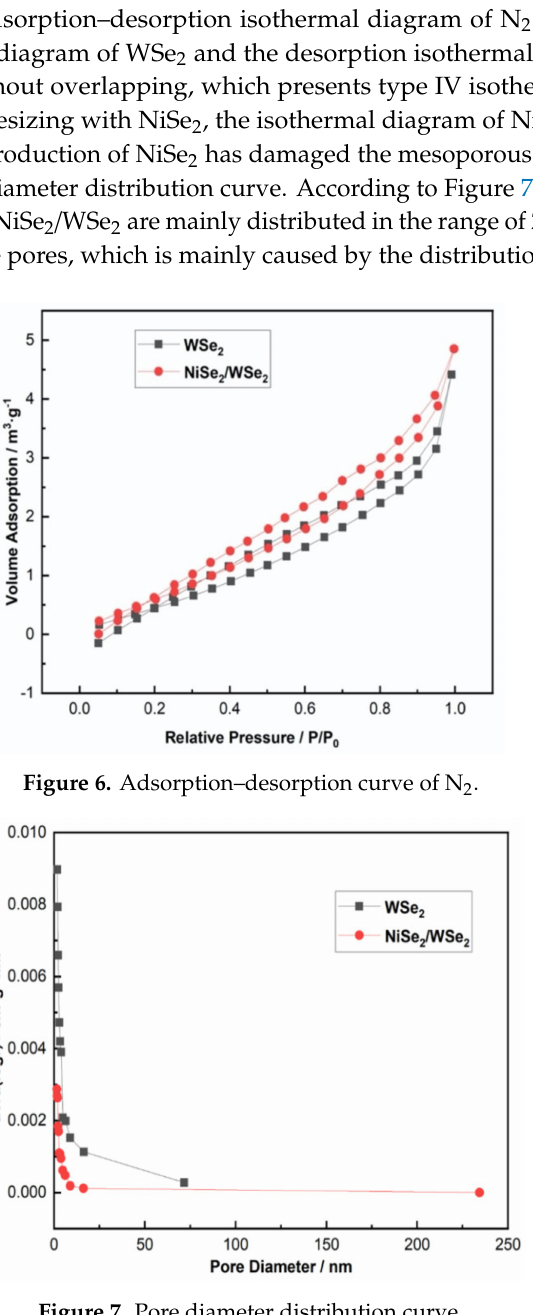
Figure 7. Pore diameter distribution